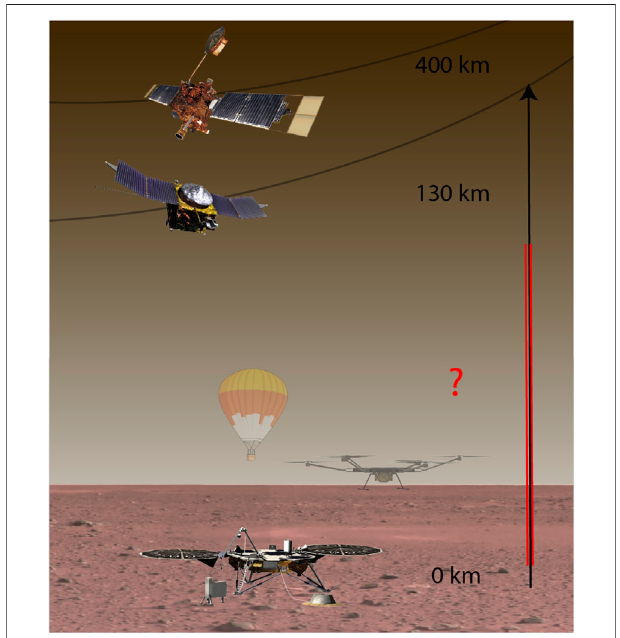
FIGURE 6 | Sketch highlighting the lack of data coverage between surface and orbital